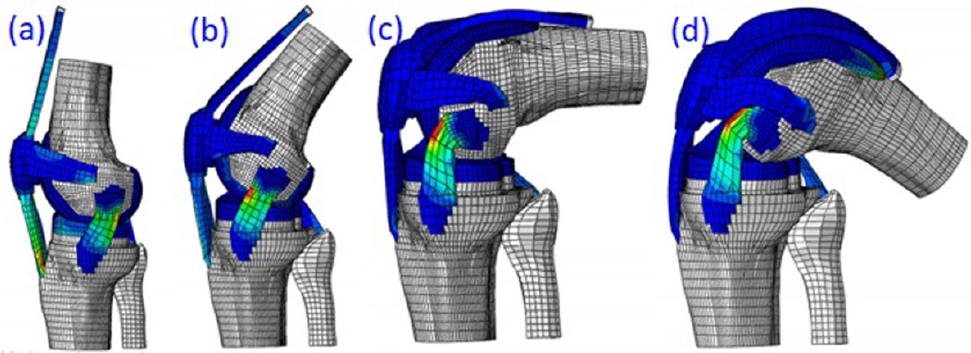
◦ ; ( b ) 30 ◦ ; ( c ) 90 ◦ ; ( d ) 135 ◦